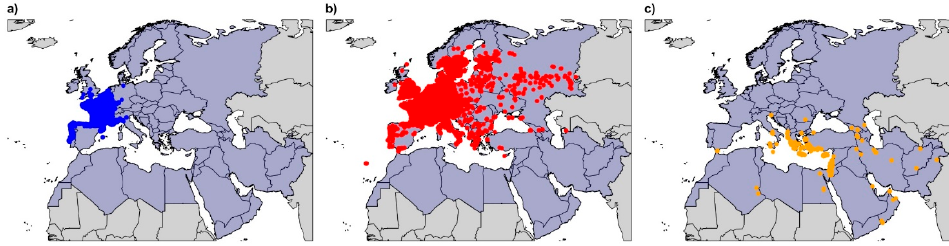
Figure 2. Distribution of Vespa velutina nigrithorax ( a ), V. crabro ( b ) and V. orientalis ( c ) in the western palearctic and saharo-arabian zoogeographic region (violet area of the map). The temporal range of the data is 1990–2021.